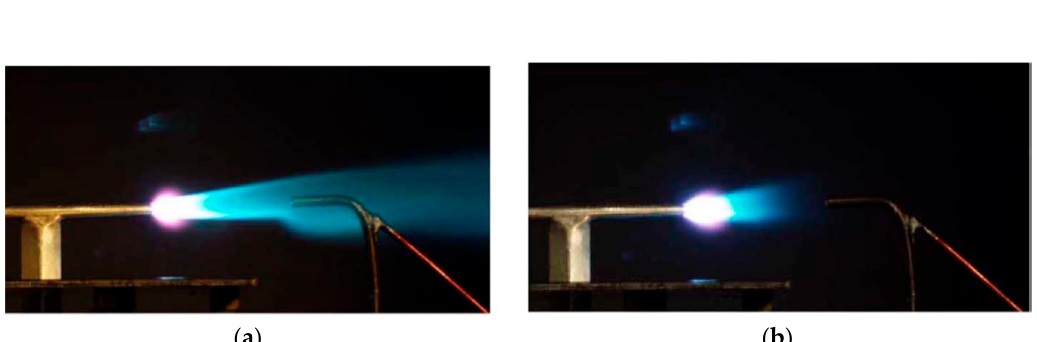
Figure 5. Deeply undercritical MW discharge in airflow with propane injection [56]. Airflow is from left to right: ( a ) 30 m/s; ( b ) 200–500 m/s. Pitot probe is located on axis of torch. Reprinted from [83] with permission from authors.